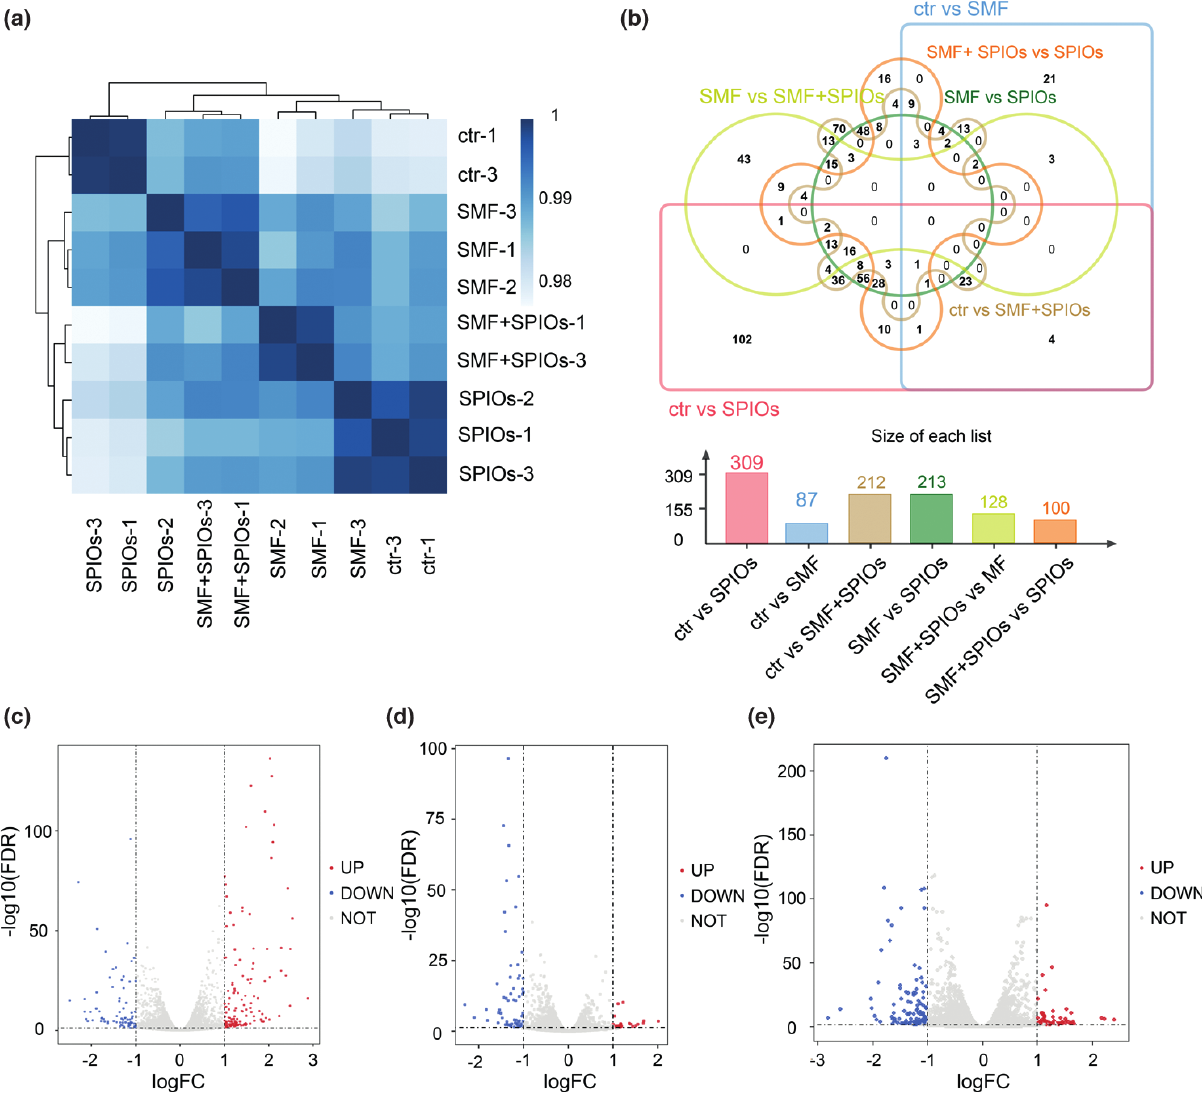
Fig. 1. Transcriptomic analysis of NSCs sourced from different treatment groups and control group. (a) Sample clustering analysis for all replicates in different groups of NSCs. (b) Venn diagram performing the number and distribution relationship of differentially expressed genes in different groups. (c), (d), and (e) present volcano plots of differentially expressed gene between SPIOs vs control group, SMF vs control group, the SMF + SPIOs vs control group, respectively. For the convenience of map- ping, the – log10(FRD) is often taken as the ordinate and so is the transverse coordinate. Red dots: upregulated expression; blue dots: downregulated expression; gray dots: no obvious differential Citation: STEMedicine 2022, 3(3): e139 - http://dx.doi.org/10.37175/stemedicine.v3i3.139